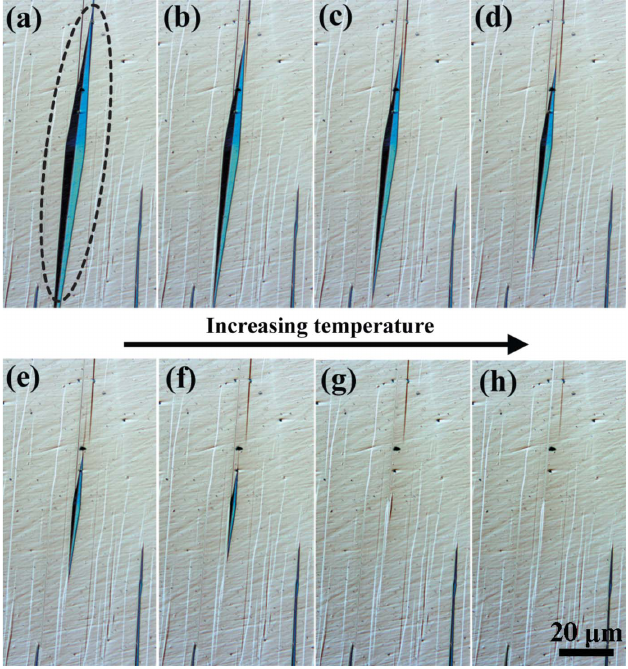
Figure 2 ( a )–( h ) Optical micrographs obtained under polarized light, showing the microstructural evolution of diamond-shaped 7M martensite in austenite with increasing